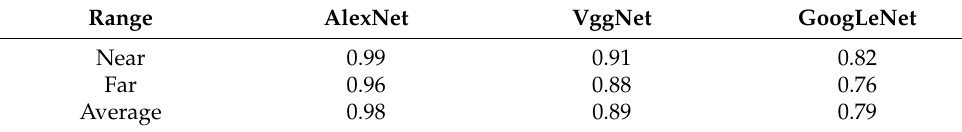
Table 7. AUC comparison under range